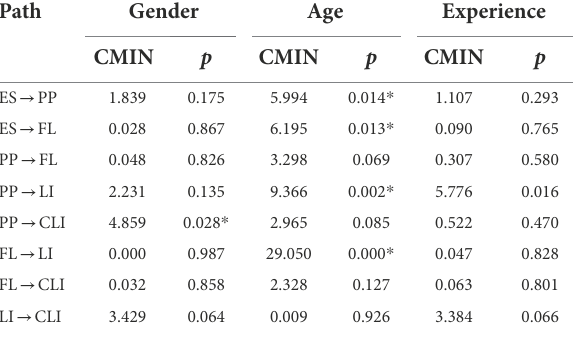
TABLE 10 Results of mediation effect.